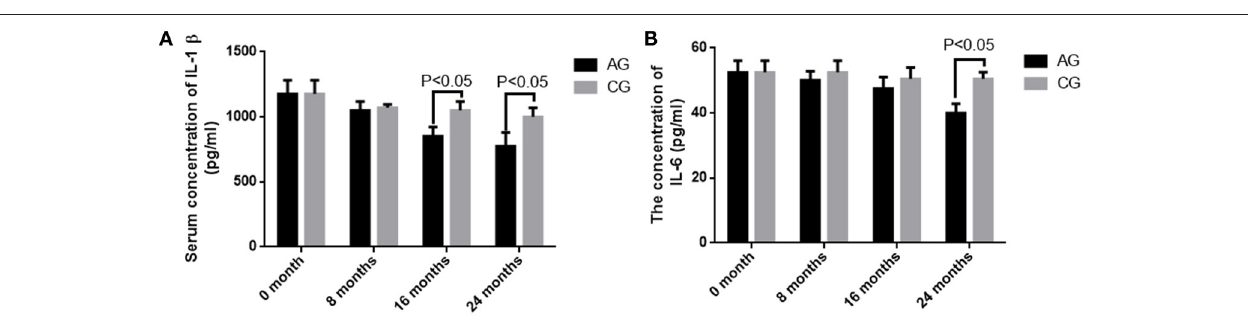
FIGURE 7 | The concentrations of IL-1 beta and IL-6 in blood samples. (A) The serum level of IL-1 beta. (B) The serum level of IL-6. All data were presented as mean values ± SD . There are statistically significant differences if P <